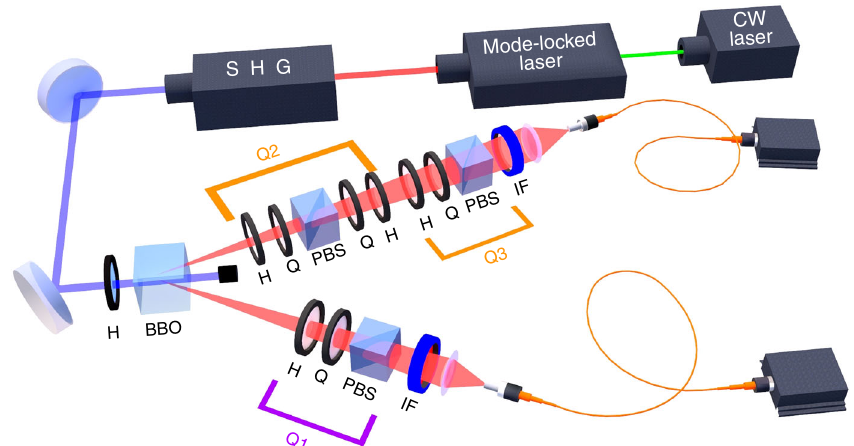
Fig. 2 Experimental setup. A CW laser at 532 nm pumps a Ti:Sapphire crystal in an optical cavity, generating a mode-locked laser at 808 nm with a 76 MHz repetition rate. The pulsed laser is frequency doubled by second harmonic generation (SHG) and then injected into a 0.5-mm-thick β -barium borate (BBO) crystal, where degenerate non-collinear type-II parametric down-conversion (PDC) occurs. By spatially selecting the photons belonging to the intersections of the two PDC cones and properly compensating the temporal walk-off between the horizontal ( H ) and vertical ( V ) polarizations by adding a 0.25-mm- thick BBO crystal in both photon paths, we generate the entangled state j ψ i ¼ 1 ffiffi p j HV i (cid:2) j VH ið Þ . Afterwards, two polarisation measurements (Q2 and (cid:2) 2 Q3) can be performed in sequence on branch A and one (Q1) on branch B. Correlations among them allow demonstrating violation of monogamy relation for PDO, simulating the scenario of OTC. H: half-wave plate; Q: quarter-wave plate; PBS: polarising beam splitter; IF: interference fi